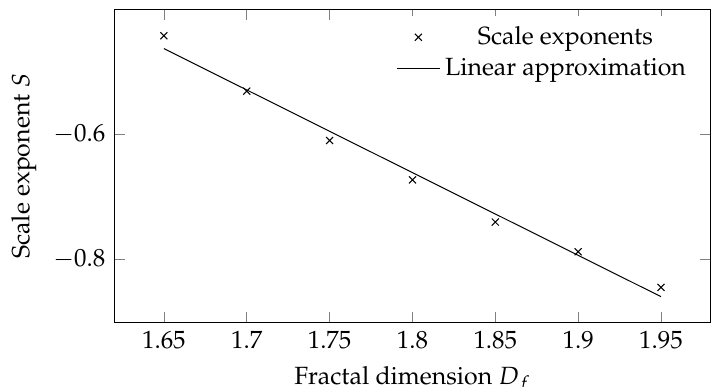
Figure 6. Relation between fractal dimension D f and the scale exponent S for artificial fractal structures derived from different Hurst exponents H